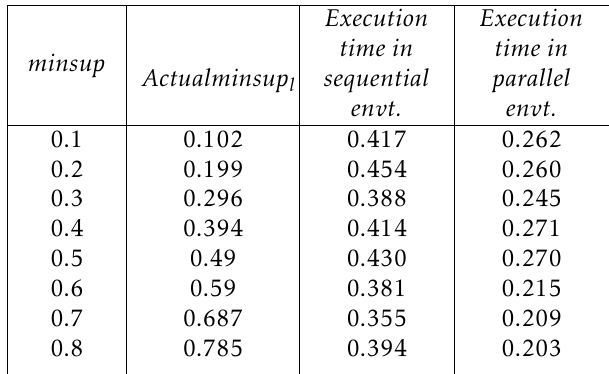
Table 14. Number of frequent singleton edges for graph stream data with varying % of relative support( relsup ) for proposed dynamic approach with fixed batch size ( DynFixed ) and